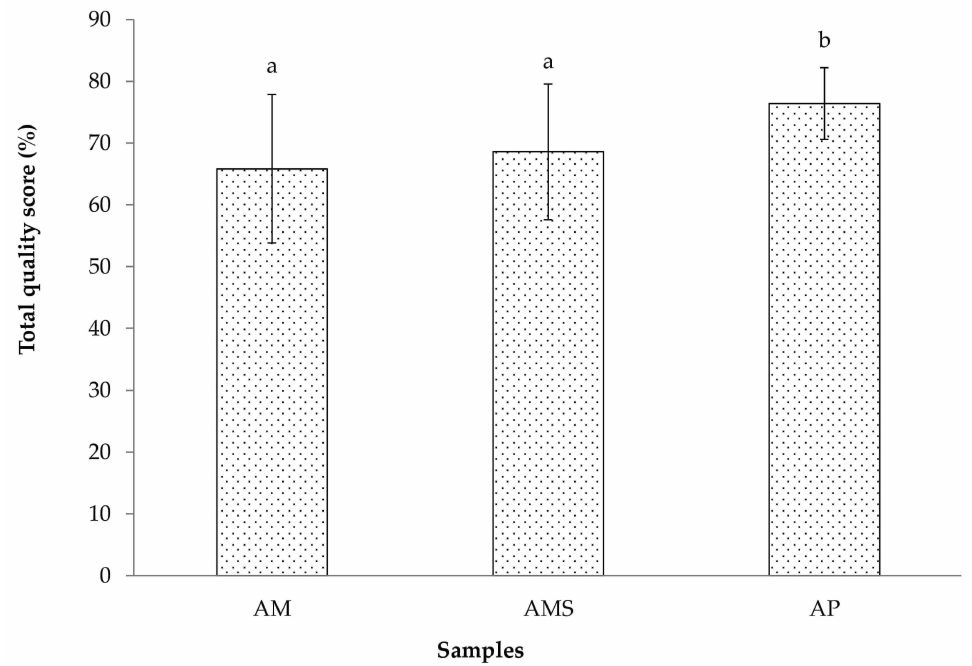
Figure 3. Total quality score for coffee-based alcoholic beverages. Error bars show standard deviation and error bars bearing different superscript differs ( p < 0.05) with one-way